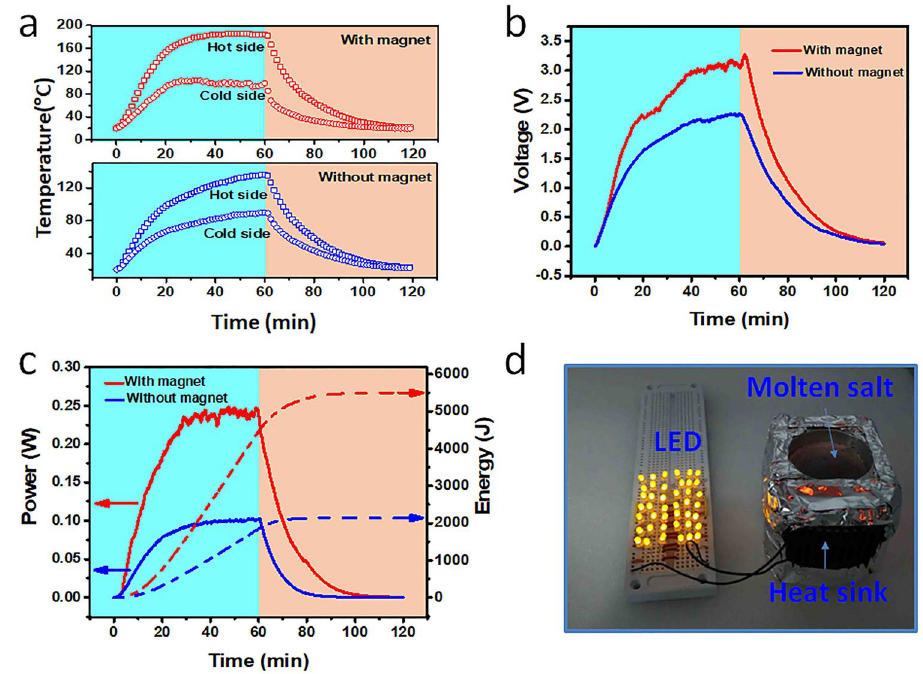
Figure 4. Solar–thermal–electric conversion performance. ( a ) Comparison of temperature variation on both sides of the thermoelectric generator under fixed (bottom) and movable (top) charging mode. ( b ) Comparison of output voltage under fixed and movable charging mode. ( c ) Comparison of generated electricity under fixed and movable charging mode. ( d ) A photograph showing that under the movable charging mode the electrical energy converted from the harvested solar–thermal energy within molten salts is able to light up 42 orange- colored LEDs in